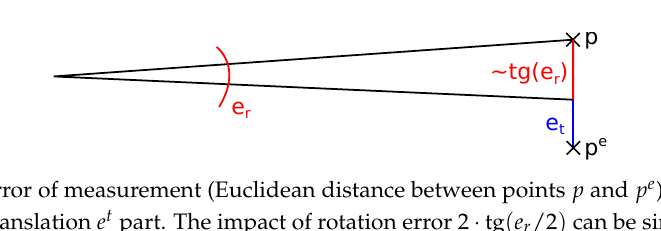
Figure 12. The overlap ( a ) between the source (blue) and the target (purple) LiDAR frame. In this case, approximately 30% of source points are within the view volume of target frame. The view volume can be effectively represented by spherical z-buffer ( b ) where range information (minimum in this case) or the information regarding empty space within the spherical grid is stored.